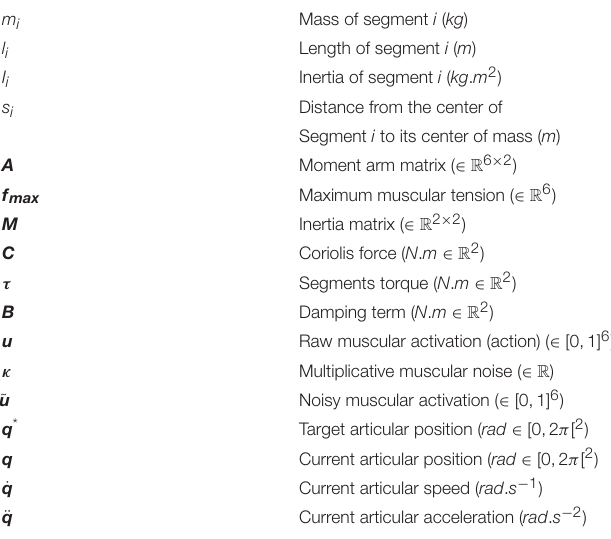
TABLE 5 | Nomenclature of the arm model